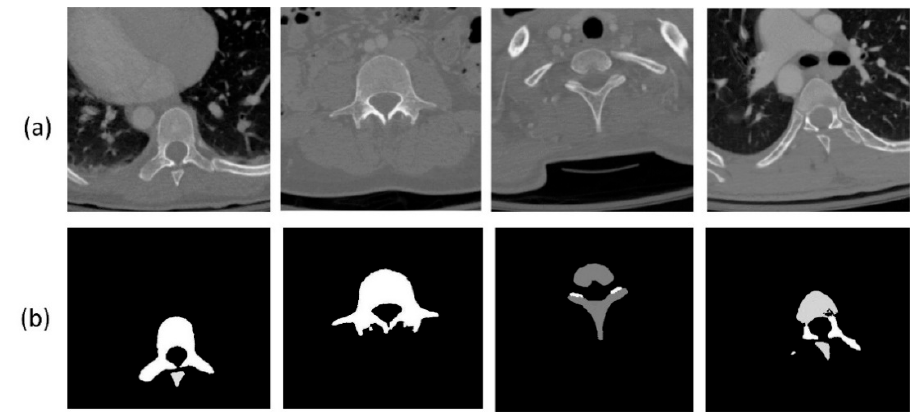
Figure 2. Example images of CT vertebrae used in the experiment: ( a ) sample raw images 512 × 512 pixels and ( b ) ground truths of selected samples, respectively.